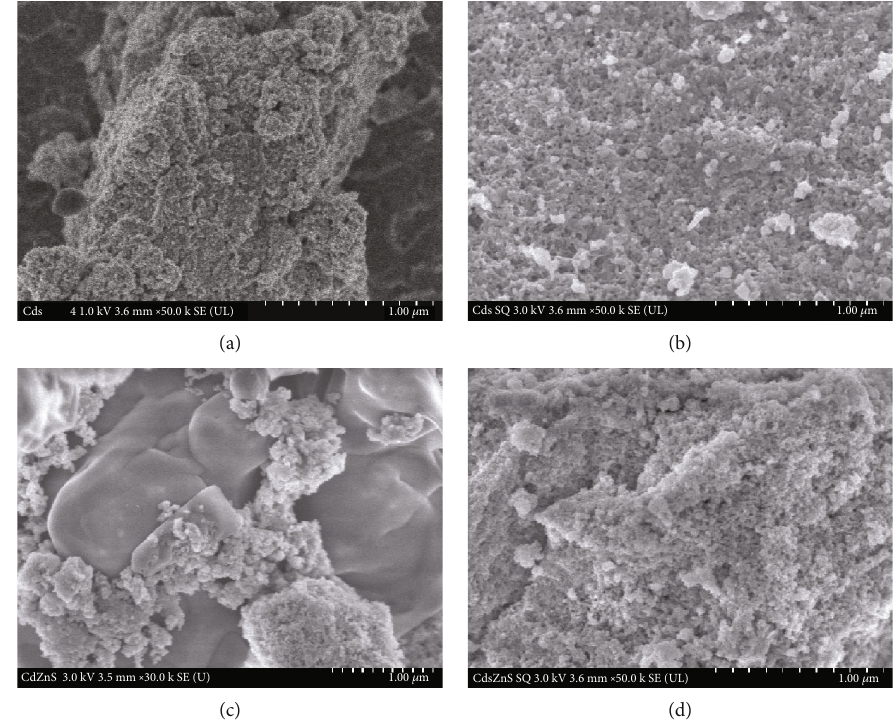
Figure 3: Micrographics of the synthesized materials with both methods: (a) CdS by coprecipitation; (b) CdS-SQ assisted with sonochemistry; (c) Zn Cd S by coprecipitation; and (d) Zn 0.2 0.8